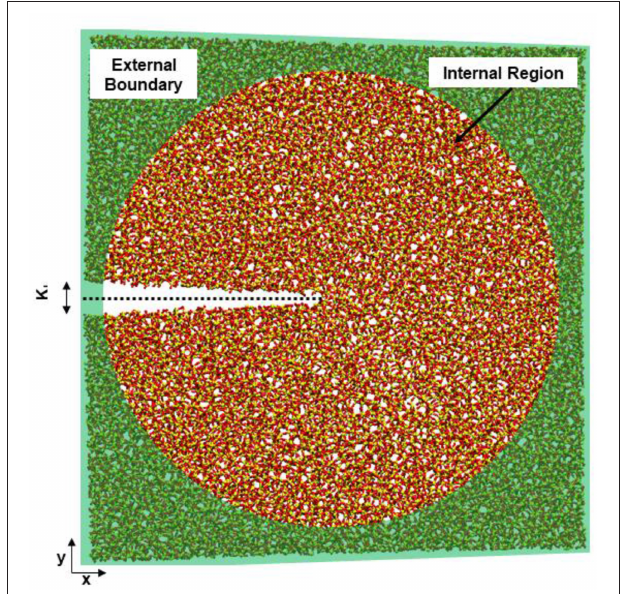
FIGURE 1 | Schematic of the quasi-2D silica system with a slit crack, oxygen atoms are red and silicon atoms are yellow. The half plane where bonds are severed to form a slit crack is denoted by a dashed line. The boundary region (radius 3.2nm), where the motion of the atoms is prescribed, is shaded green. In the internal cylindrical region, the atoms are free to relax to a minimum energy configuration while atoms in the boundary are fixed to the displacement prescribed by the mode I loading. The axis of the cylinder is out-of-plane and the thickness of the system is 2.8nm.